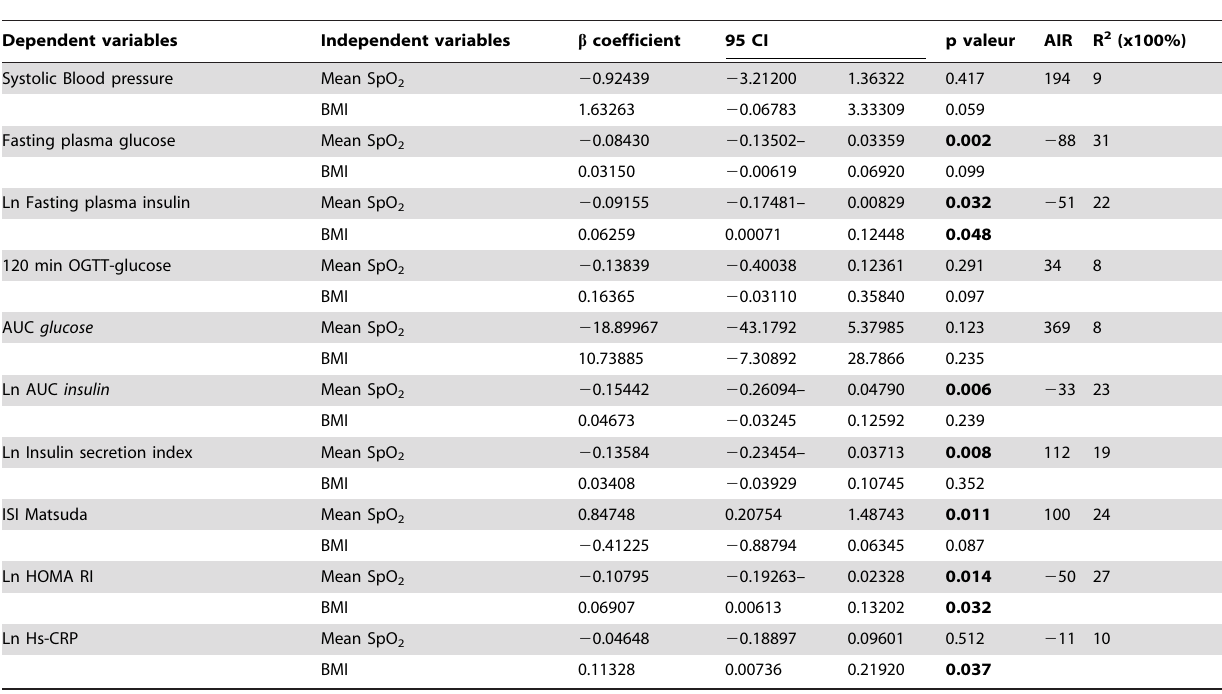
Table 4. Multivariable linear regression analyses: relative contribution of mean nocturnal SpO 2 and BMI.